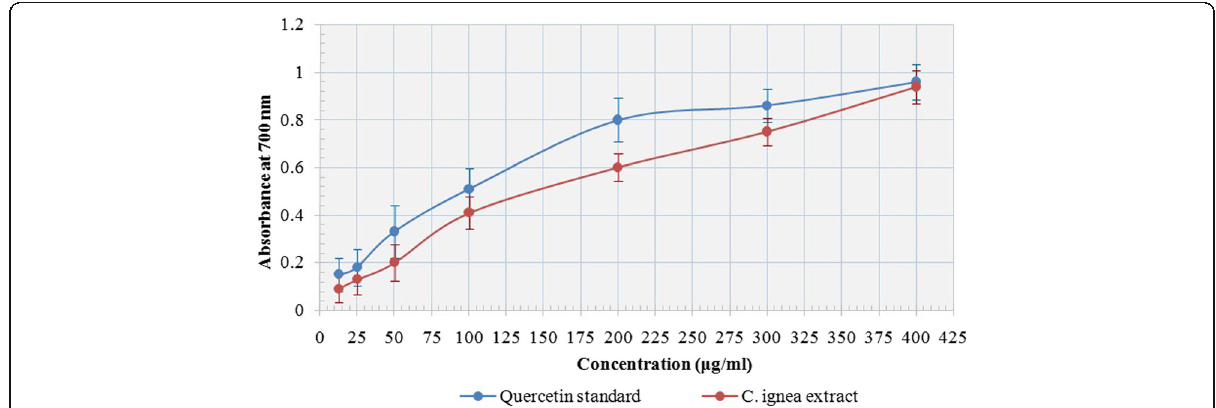
Fig. 2 Reducing power of C. ignea aerial parts extract compared with quercetin as standard. Results are given as mean±SD of three replicate